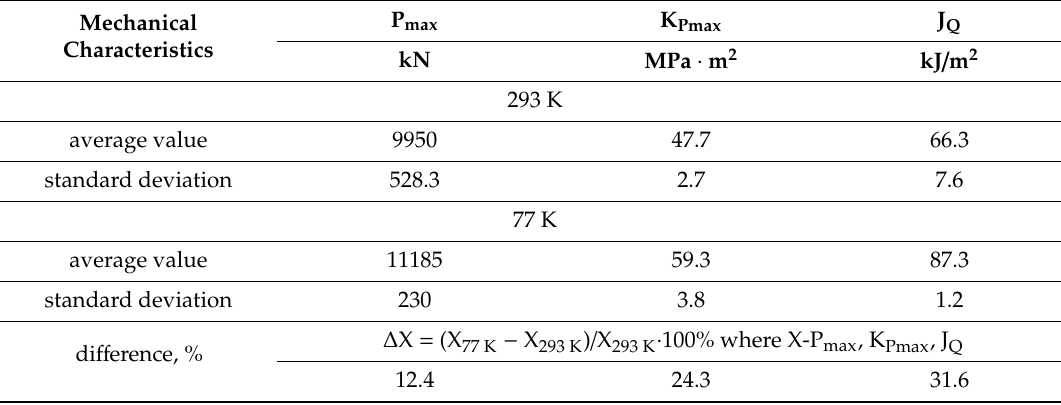
Table 2. Averaged tests results obtained by determination of the maximum experimental value of the J–J Q integral.